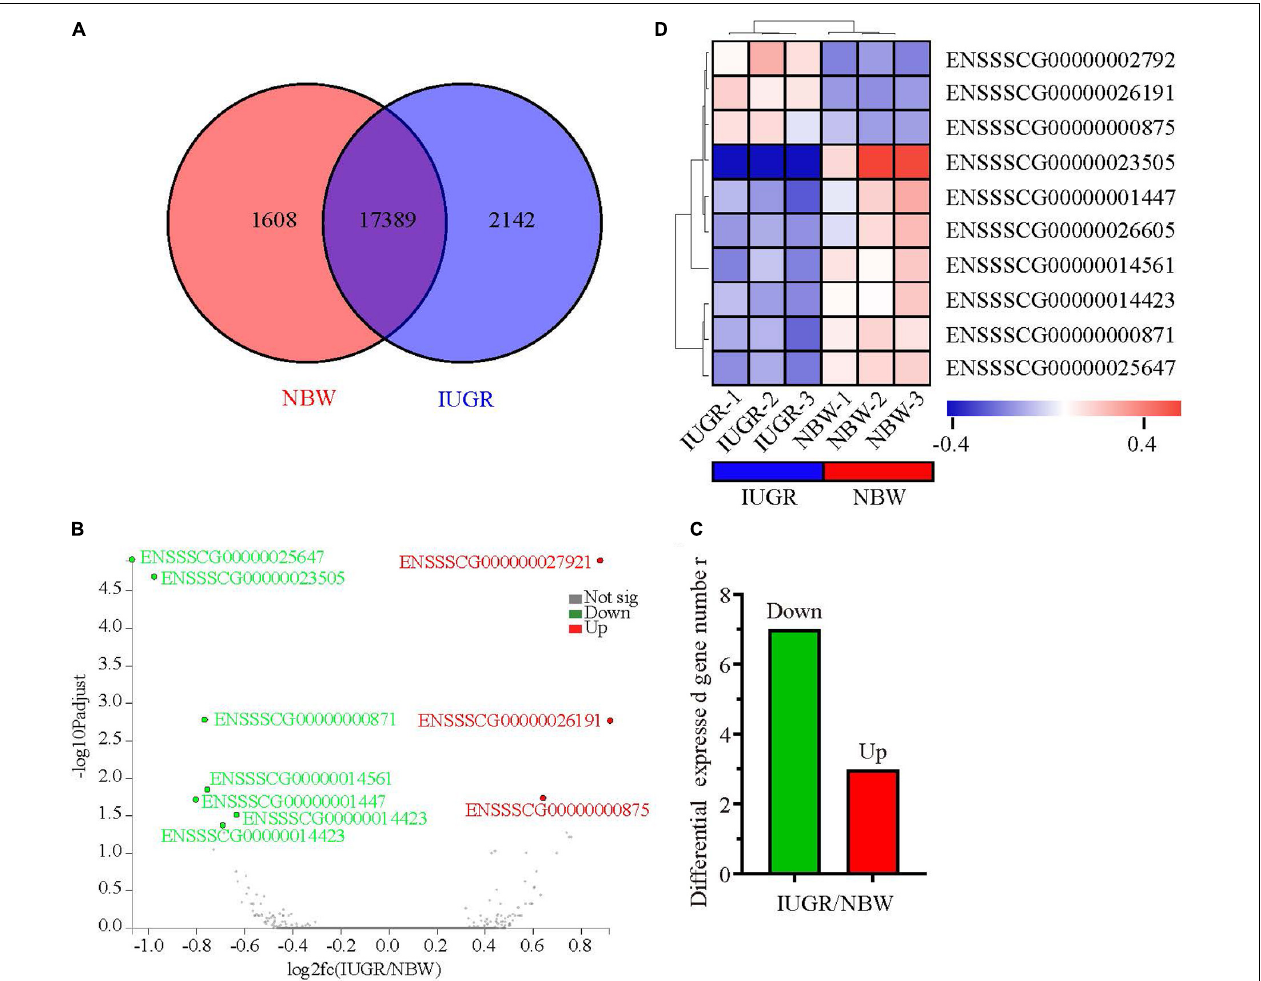
FIGURE 1 | Genome-wide distribution of differentially expressed genes between NBW and IUGR piglets at birth. (A) Venn diagram of expressed genes between NBW and IUGR piglets. (B) Volcano plots of the most significantly altered genes. (C) Heatmap diagram of differentially expressed genes between NBW and IUGR piglets. (D) Distribution of up-regulated genes in NBW and IUGR piglets.